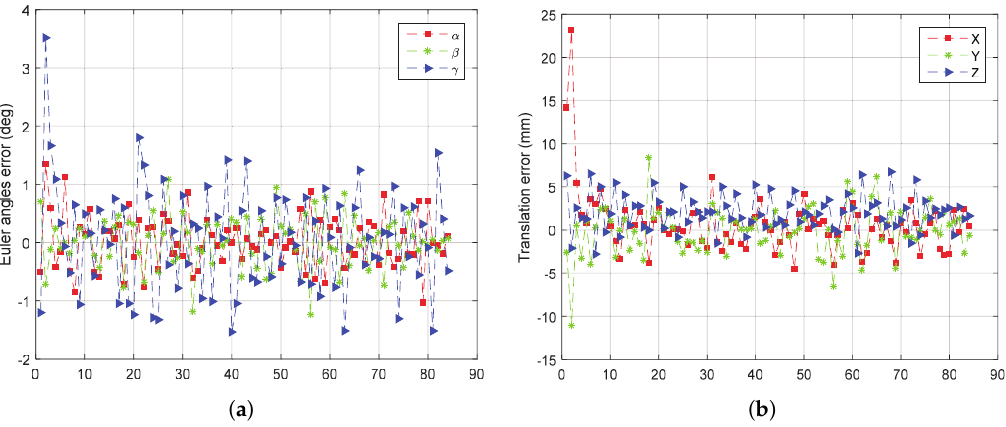
Figure 12. The error curve of ( a ) rotation and ( b ) translation of test 2.